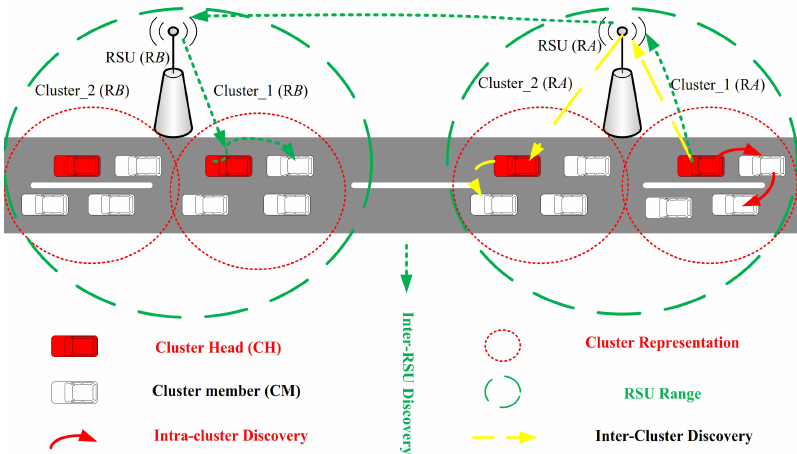
Figure 1. An overview of the suggested connectivity-based clustering